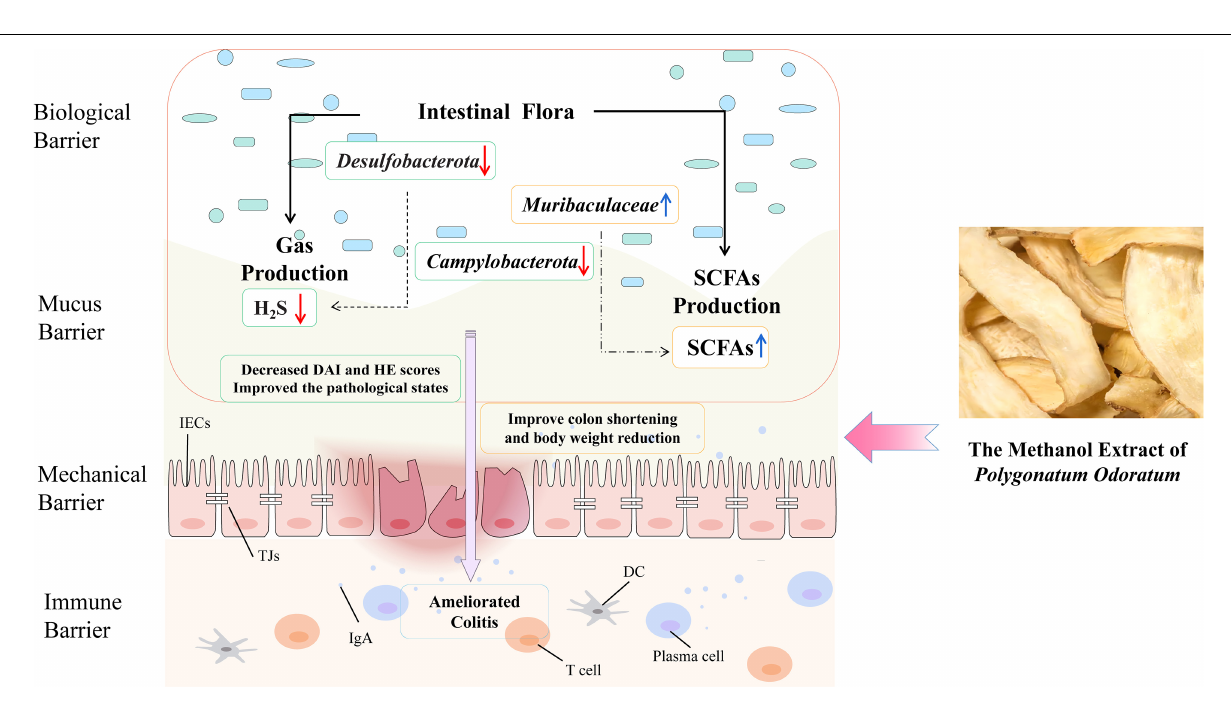
FIGURE 7 | Schematic of YZM alleviating